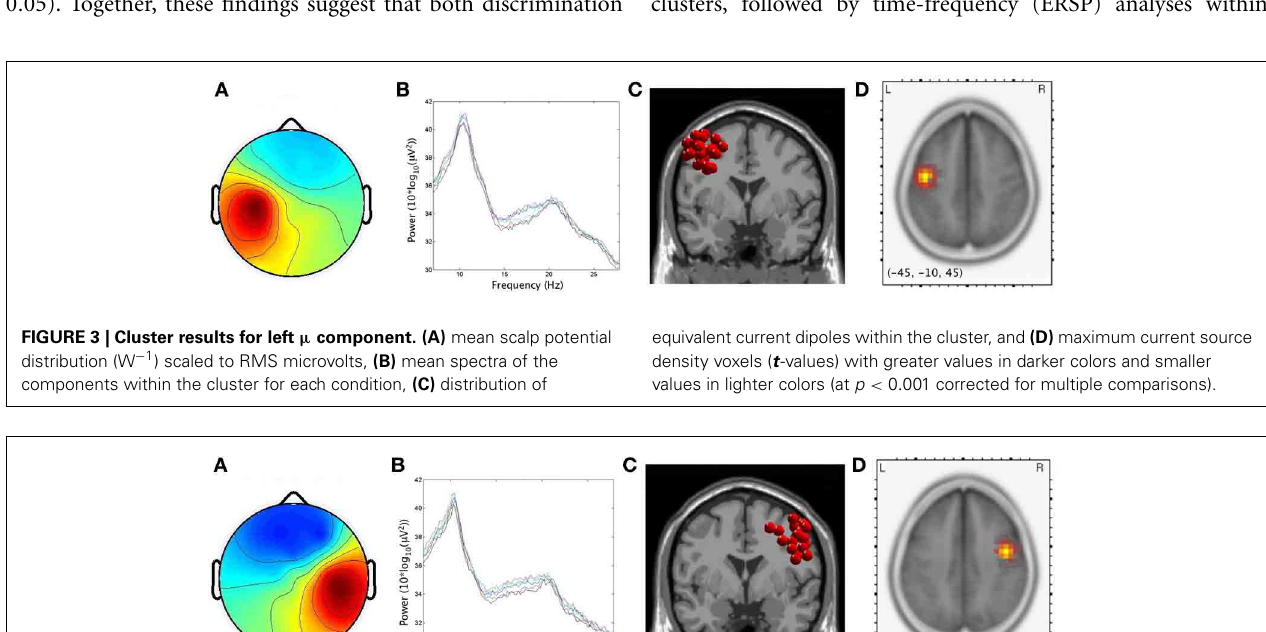
equivalent current dipoles within the cluster, and (D) maximum current source density voxels ( t -values) with greater values in darker colors and smaller values in lighter colors (at p < 0 . 001 corrected for multiple